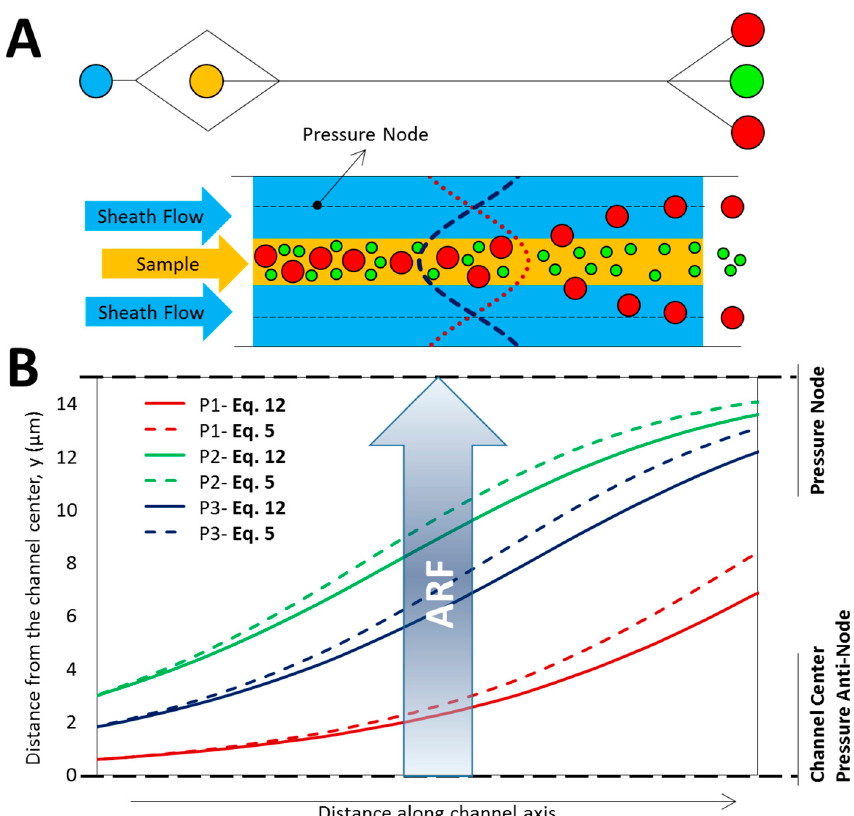
Figure 4. The influence of BPs size on their trajectory in a separation device. ( A ) Scheme of a typical separation microfluidic device. The ARF pushes the BPs toward acoustic nodes while exerted force is dependent on the BP size (Equation (5)). The BPs entering the sheath flow are collected from the side outlets, however smaller particles that are less affected by the acoustophoretic force, remain in the sample flow and are collected from the center outlet; ( B ) 10 µm BPs trajectory in microfluidic channel, affected by a vertical one-directional standing acoustic wave (SAW) with λ = 60 µm. Three similar BPs (P1, P2 and P3) are released from different vertical positions. Dashed lines stand for trajectories of BPs subjected to the ARF derived from conventional formulation with small particle assumption (Equation (5)). The actual trajectory considering the BP size (Equation (12)) are shown by solid lines. Since f m < 1, some BPs may not succeed to enter the sheath flow and therefore the predicted efficacy of separation reduces. The distance along the channel axis is not in scale and is based on the power and inflow channel velocity.